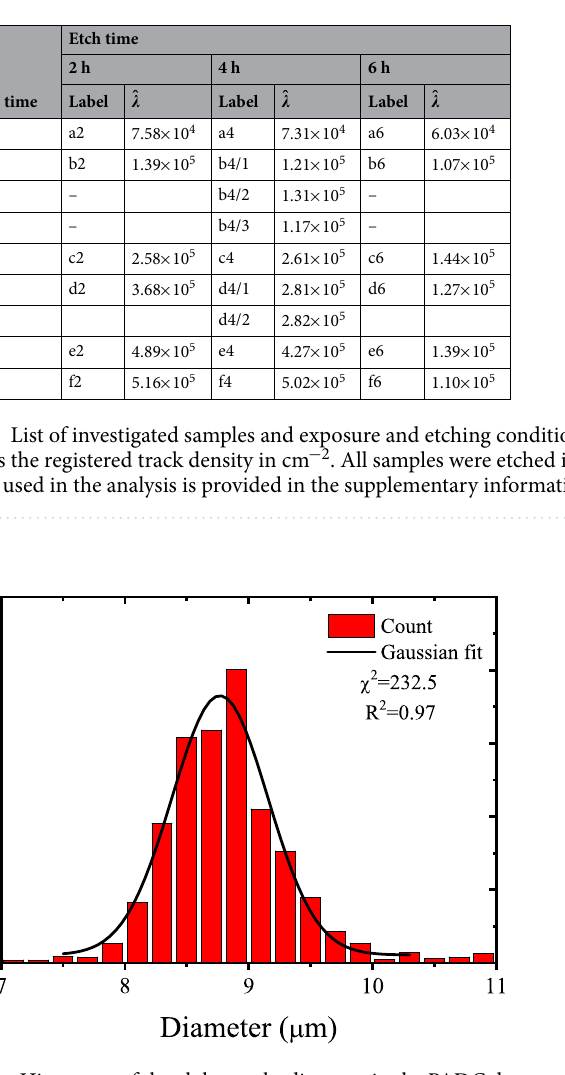
Figure 3. Histogram of the alpha tracks diameter in the PADC detector for samples d4/1 and